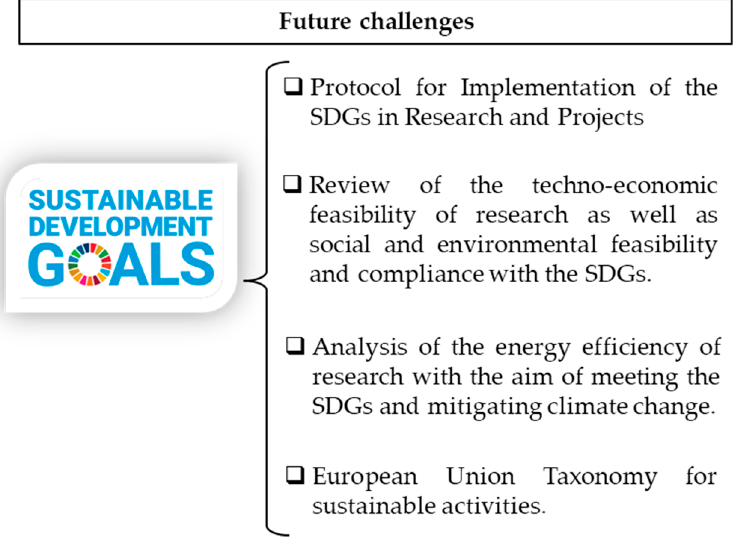
Figure 7. Future challenges.